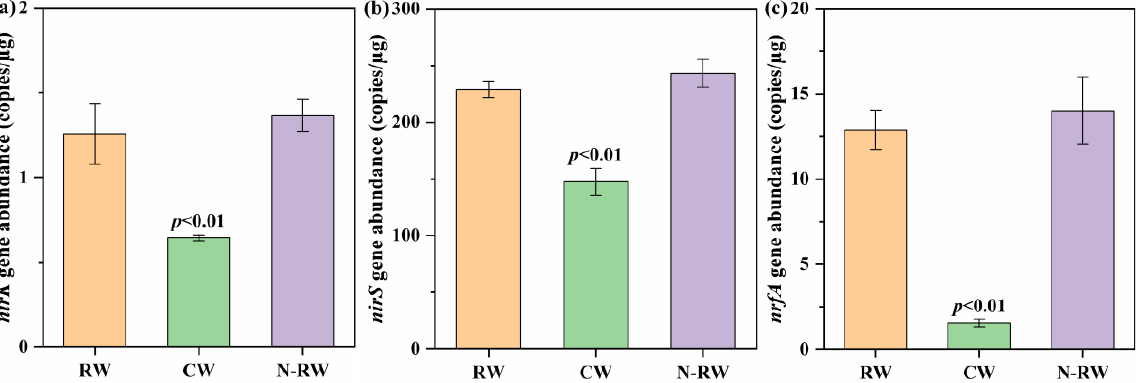
Figure 8. ( a ) nirK gene abundance; ( b ) nirS gene abundance; ( c ) nrfA gene abundance in three groups of wetland systems. Note: p < 0.01 compared to RW.